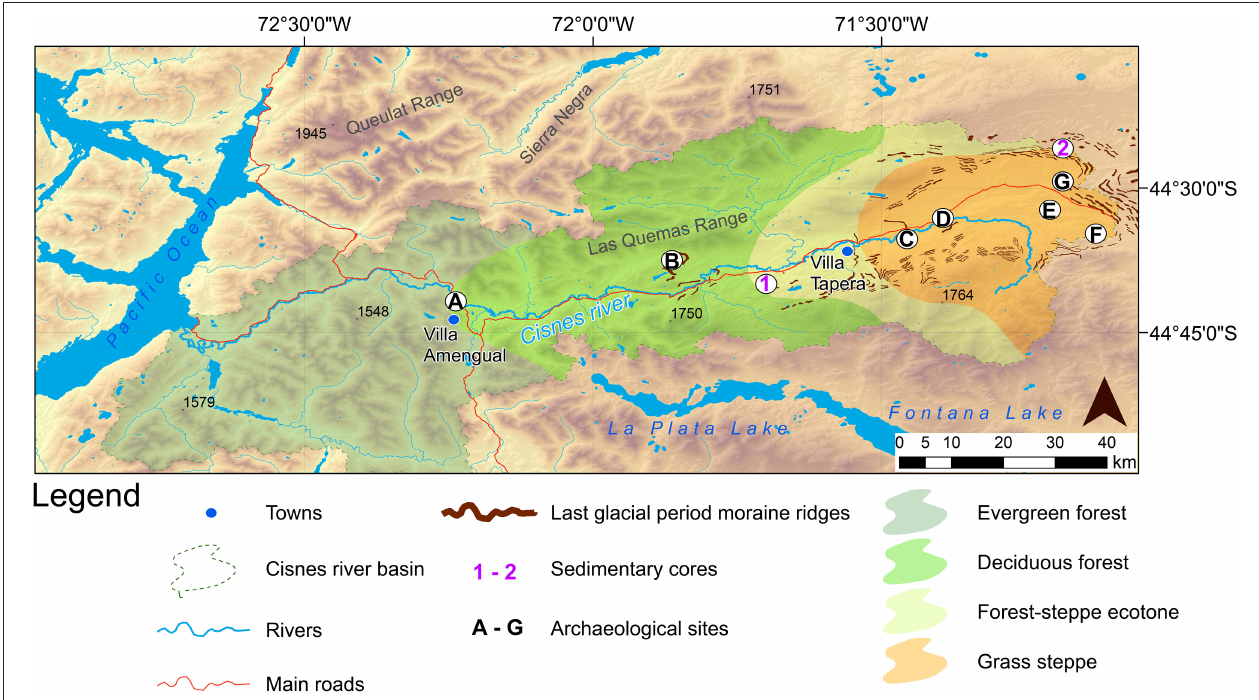
FIGURE 2 | Map of the CRV showing vegetation distribution, main geomorphological features, archeological sites (A, El Toro; B, Las Quemas; C, Chenque Cisnes; D, Winchester 1; E, La Cantera 1; F, Appeleg 1; G, El Chueco 1), and sedimentary cores (1, Mallín El Embudo; 2, Lake Shaman).